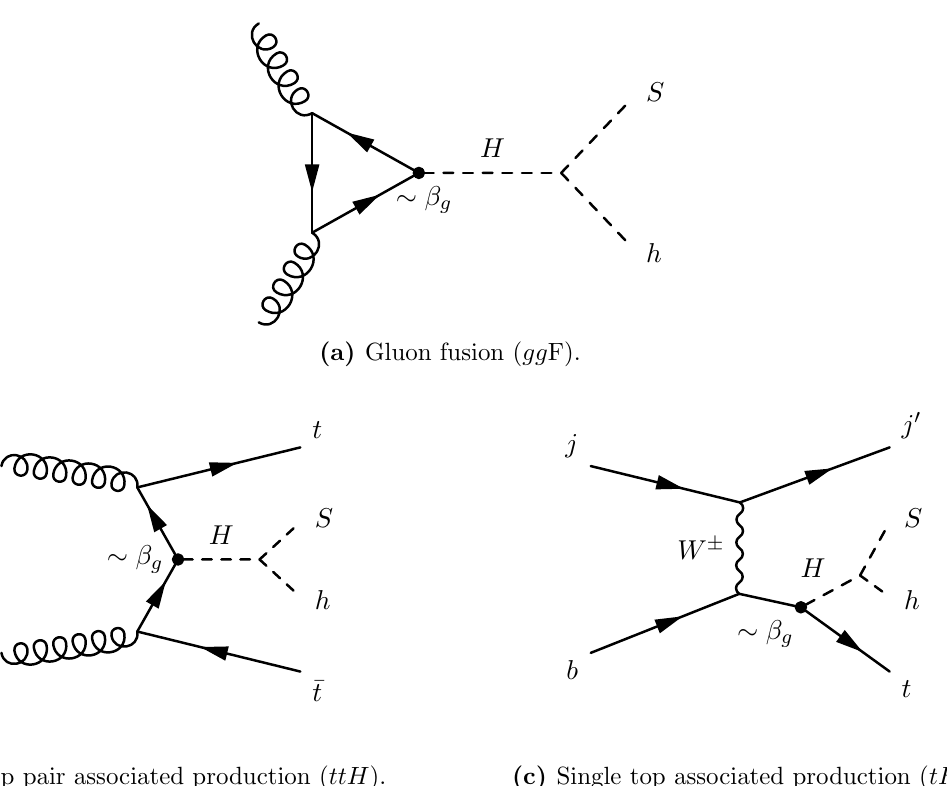
Figure 1 . The representative Feynman diagrams for the leading order production modes of H and its subsequent decay to Sh . For the sake of clarity, the H { t { t vertices have been given a label in order to show how the parameter (cid:12) g a(cid:11)ects the